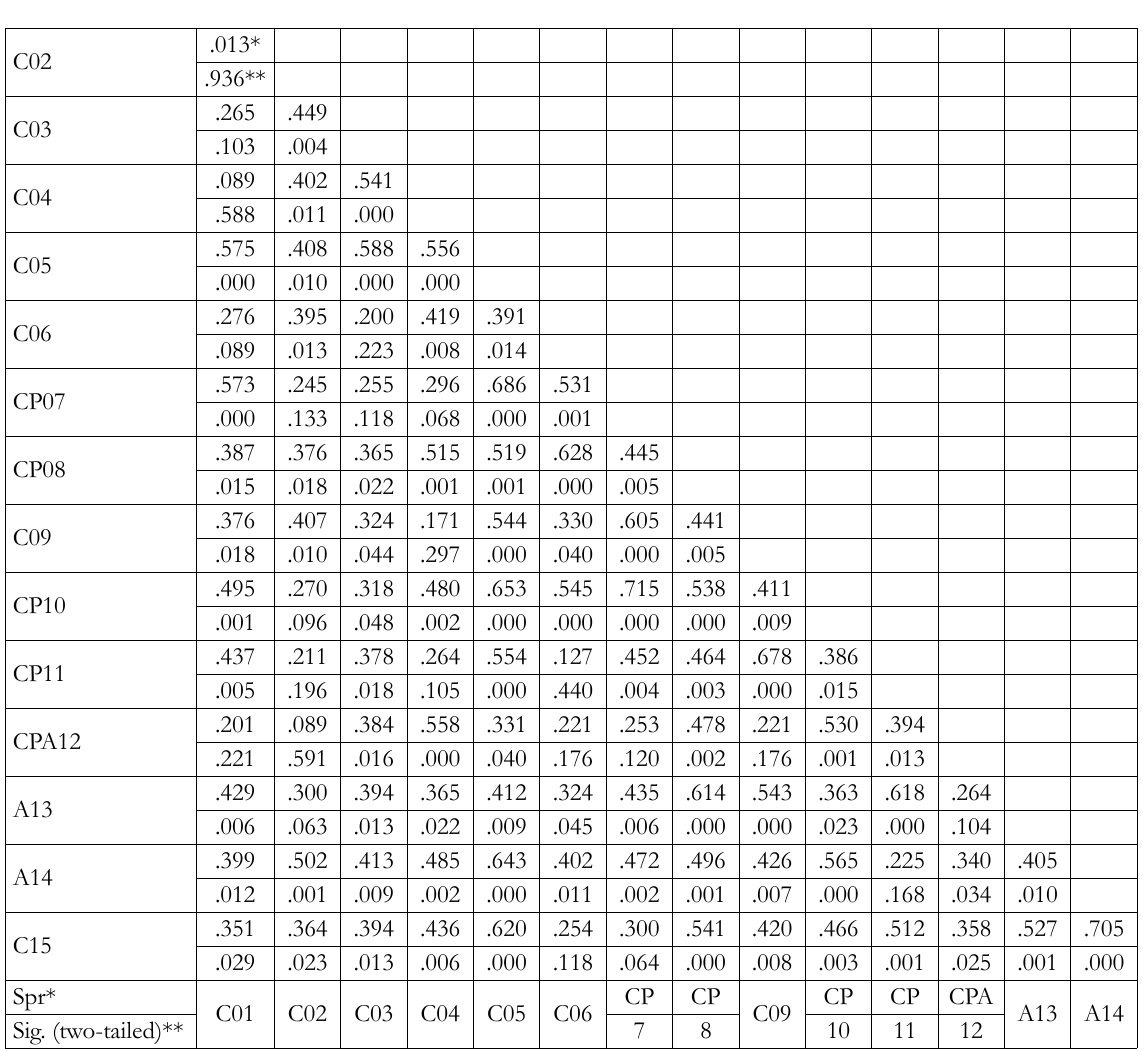
Table 6. Bivariate correlations between the items of the CAPABP questionnaire applied post-intervention in the EG (N=39)